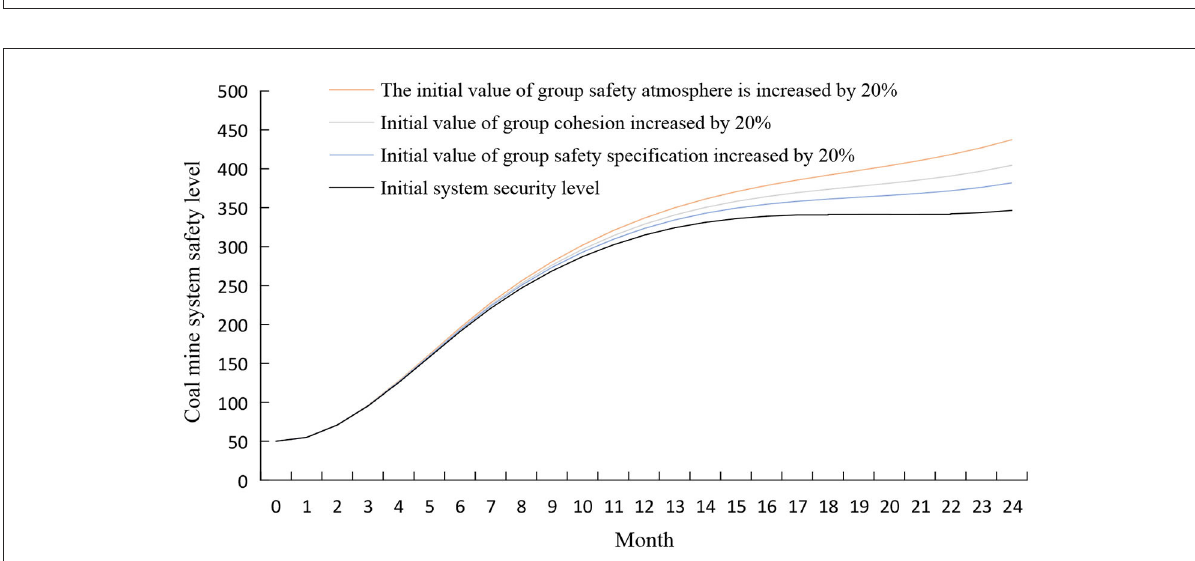
FIGURE10 Simulation results of coal mine system safety after the intervention of group